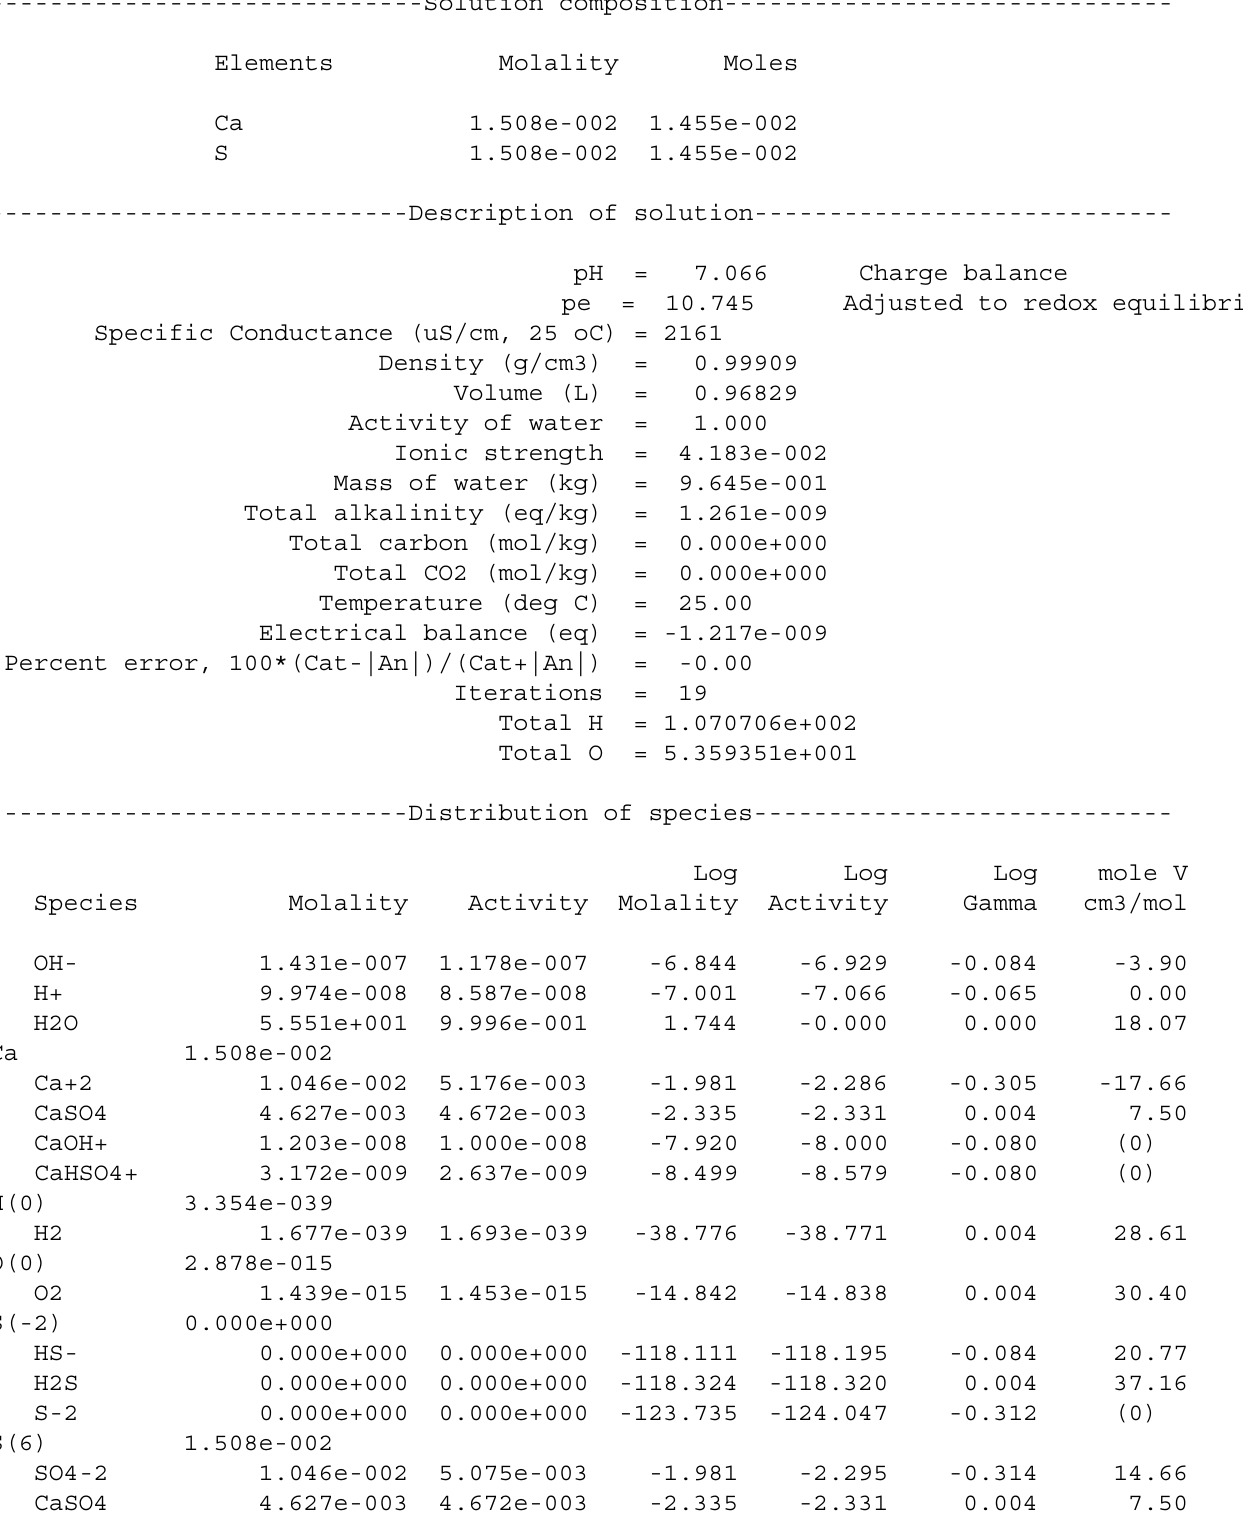
Table 13. Selected output for example